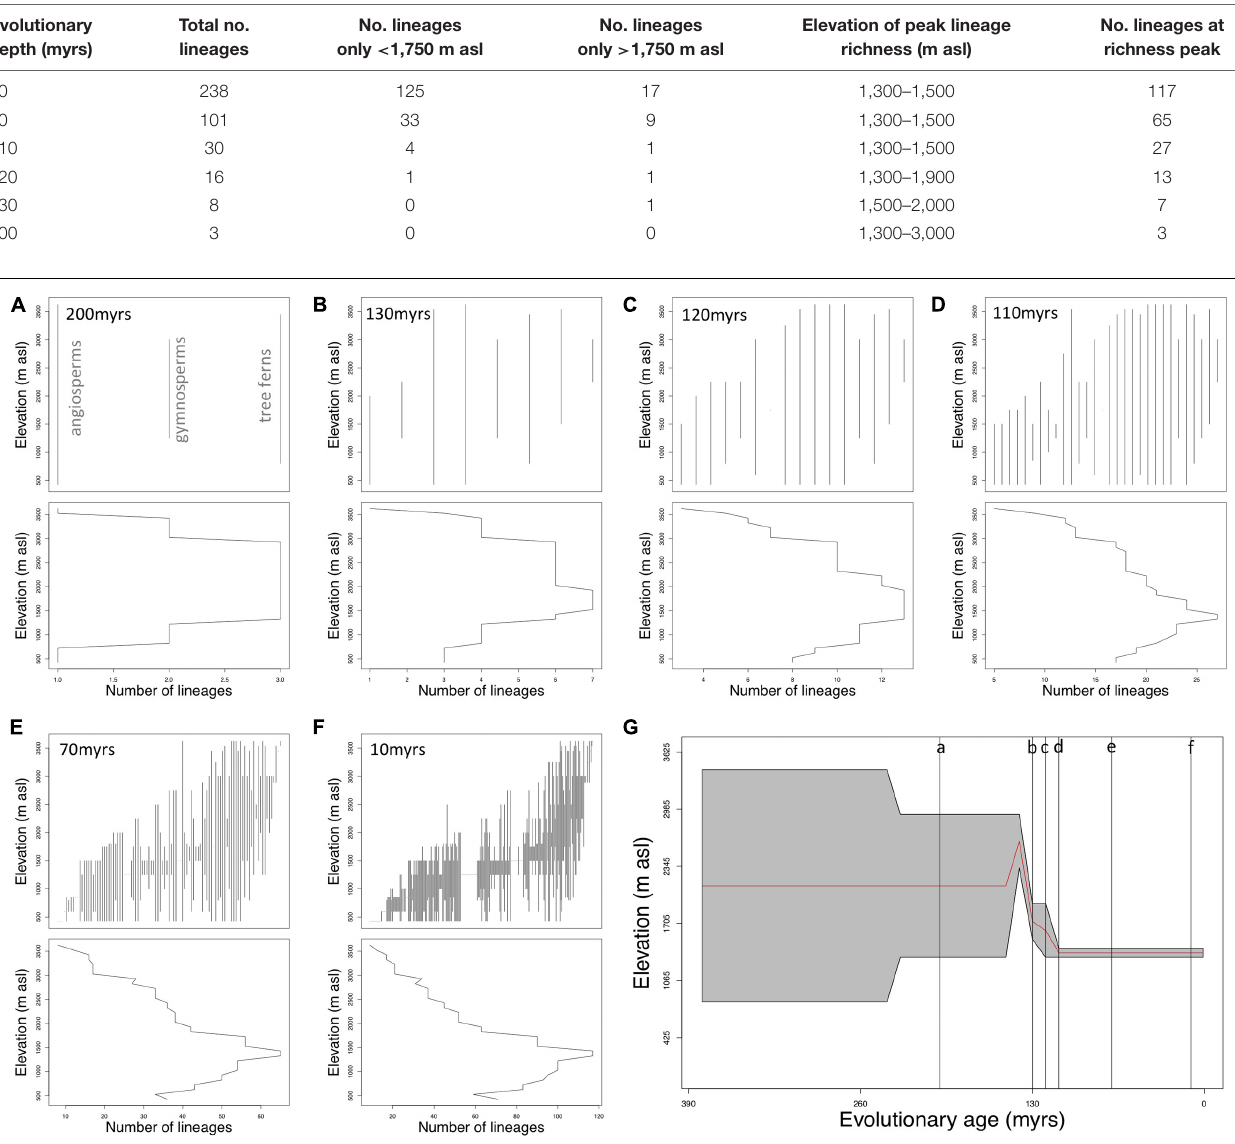
TABLE 2 | Summary of lineage elevational range trends and richness at six illustrative evolutionary depths. Evolutionary Total no. depth (myrs) lineages